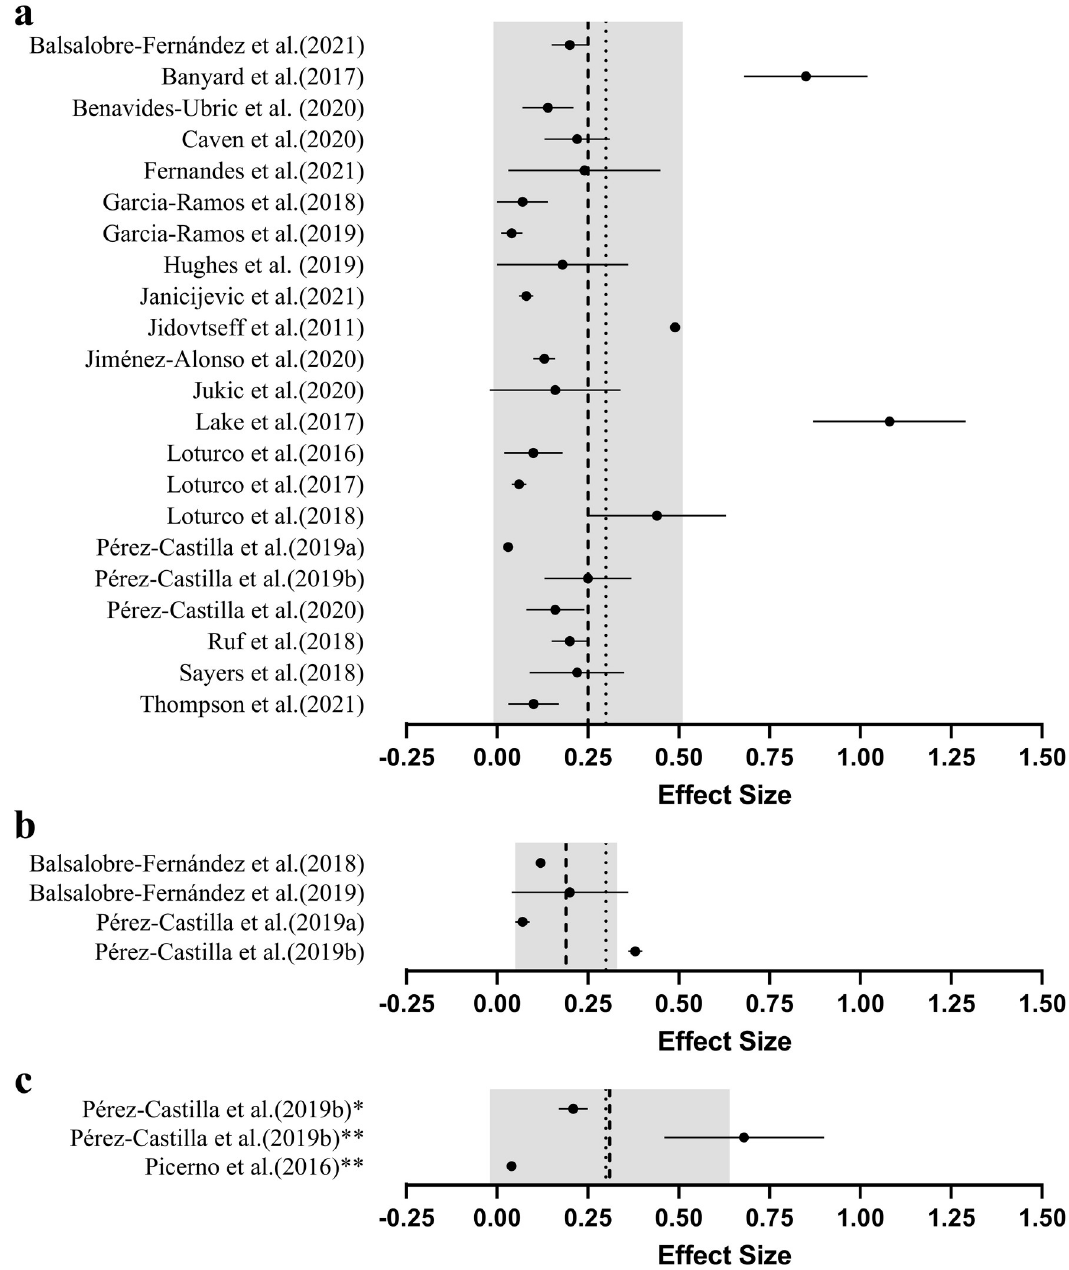
Fig 6. Mean ( ● ) effect sizes ( ± SD), grouped average (---) and recommended maximum effect size ( ��� ) for magnitude of difference between predicted and actual 1RM by the velocity monitoring device used; a.) linear position transducer, b.) smartphone application, c.) other devices. � camera-based optoelectronic system, �� inertial measurement units. The grey band represents the standard deviation of the pooled effect sizes. Note : Effect sizes closer to zero indicate greater validity (i.e., smaller difference between actual and predicted